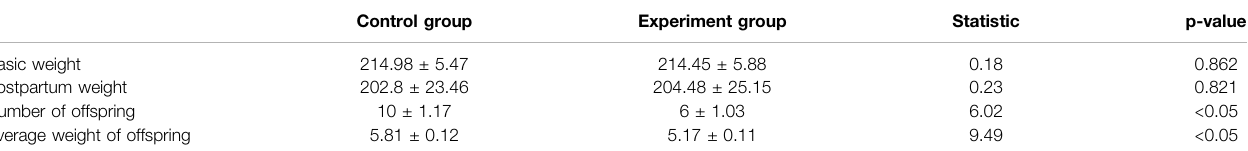
TABLE 1 | Comparison of postpartum conditions in the two groups.